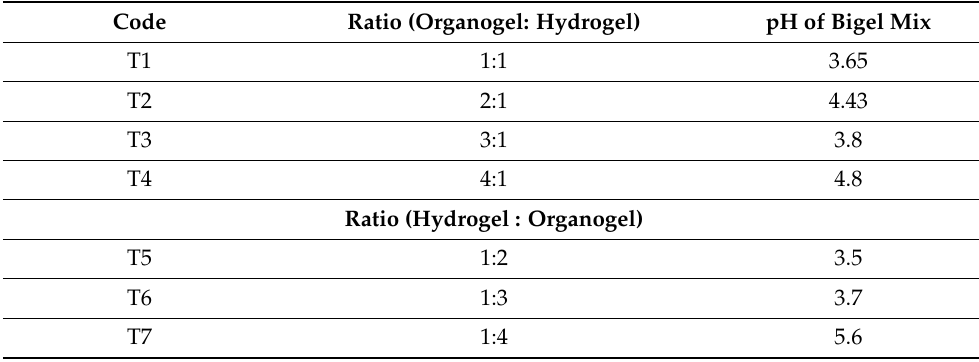
Table 6. Varying combinations of organogel–hydrogel mix for bigel